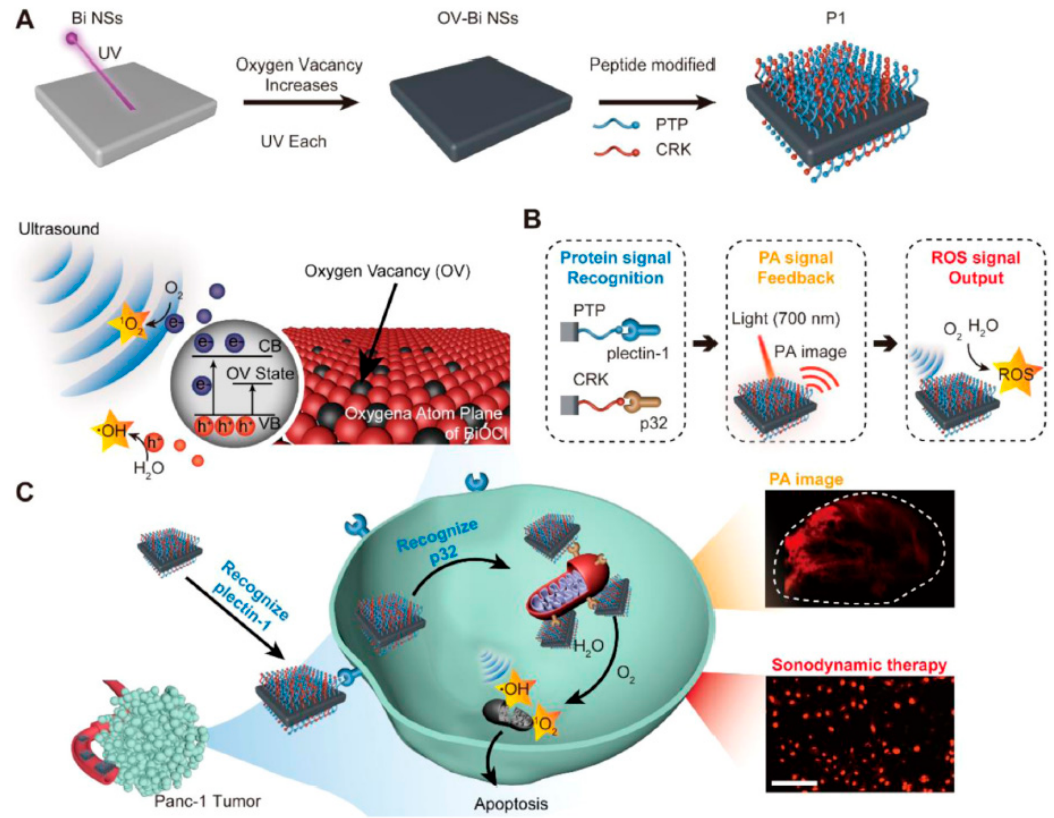
Figure 11. BiOCl nanosheets used for PA imaging-guided SDT. ( A ) Fabrication of oxygen-vacancy- rich BiOCl NSs modified with PTP and CRK; ( B ) scheme of cancer cell and mitochondrial targeting, PA imaging, and ROS generation capabilities; ( C ) scheme of PA imaging-guided SDT of oxygen- vacancy-rich BiOCl NSs. Reproduced with permission from Ref. [ 66], 2021, Elsevier.